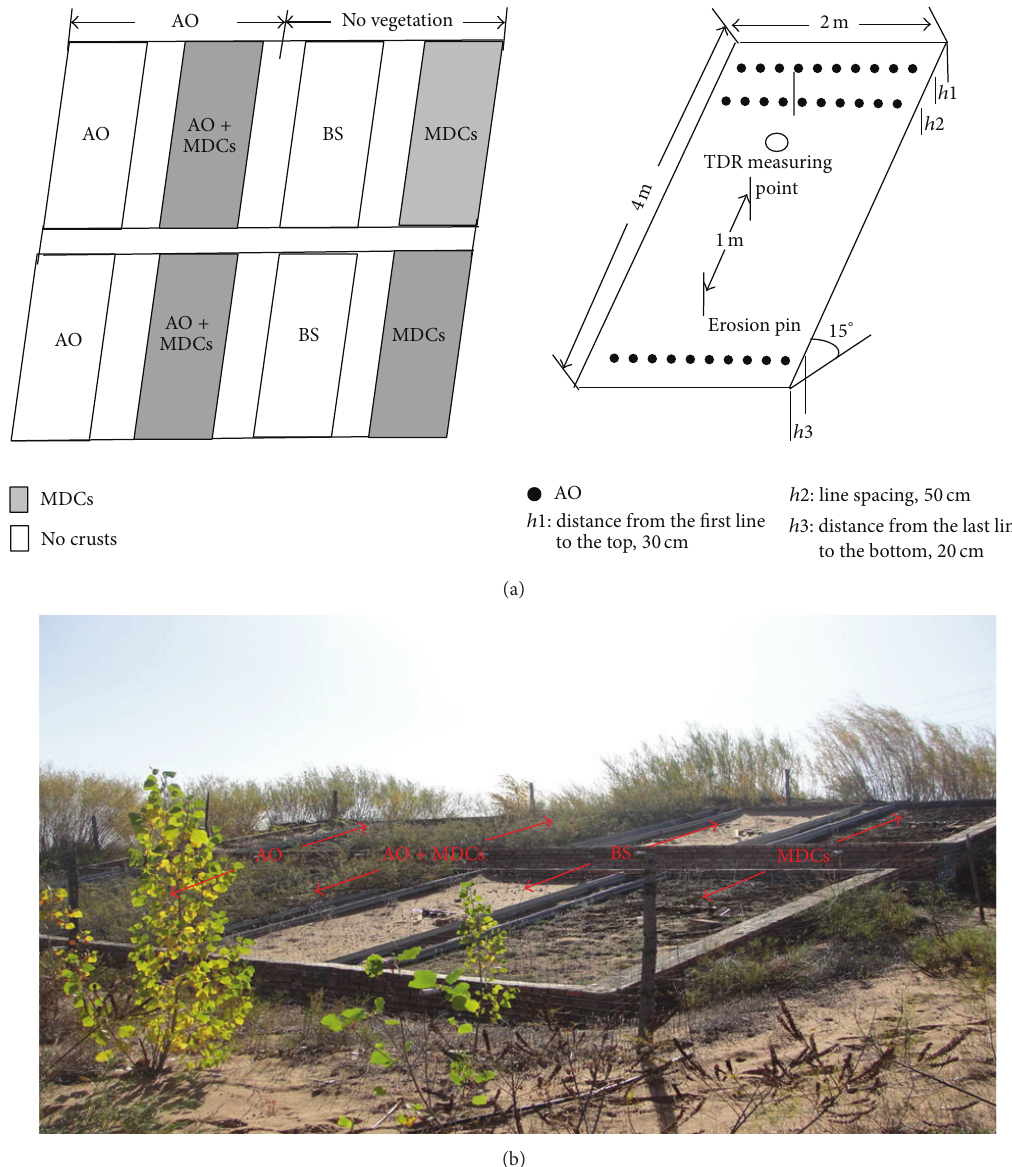
Figure 1: Sketch map (a) and photograph (b) of the 8 plots.